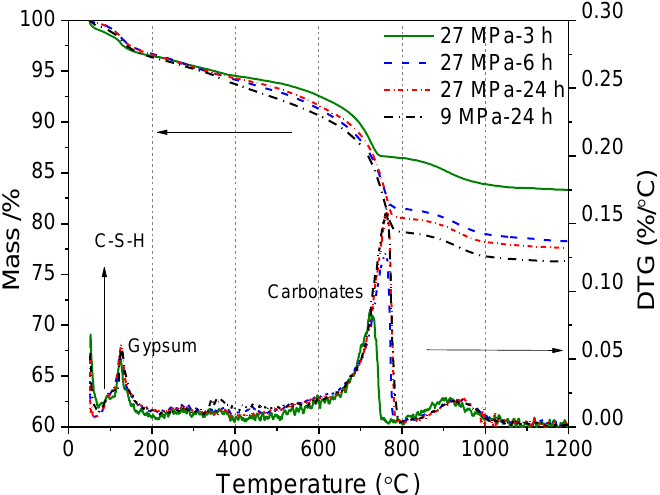
Figure 10. TG – DTG analyses of samples with different molding pressures and curing times. Figure 10. TG–DTG analyses of samples with different molding pressures and curing